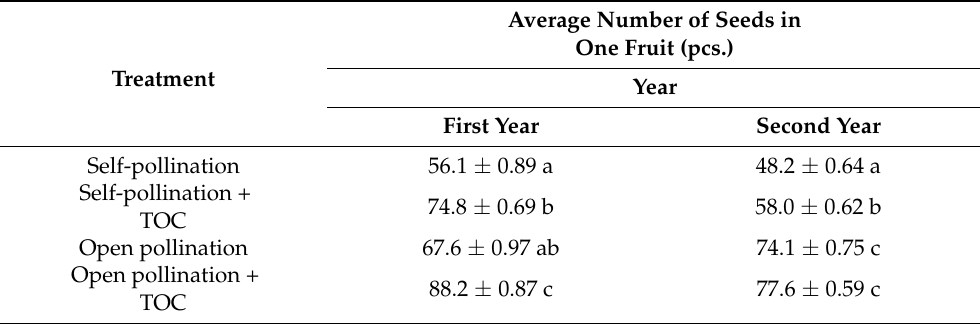
Table 3. The effect of experimental factors: type of pollination and application of titanium organic complex (TOC) on the average number of seeds in individual blueberry fruit (pieces).